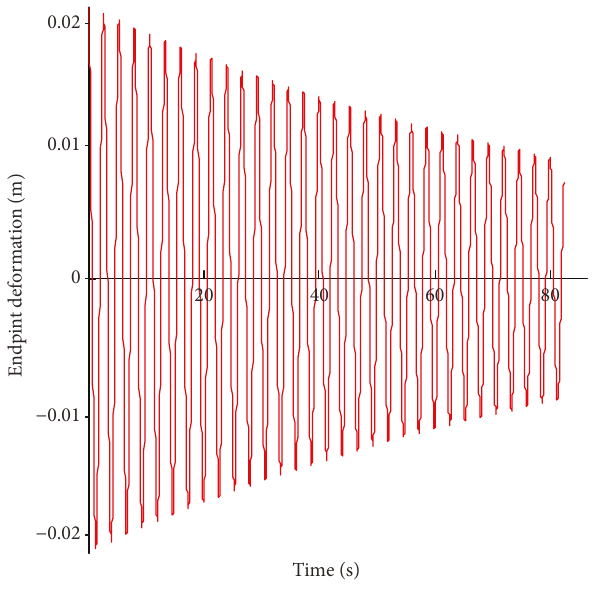
Figure 2: Vibration response of the uncontrolled arm.